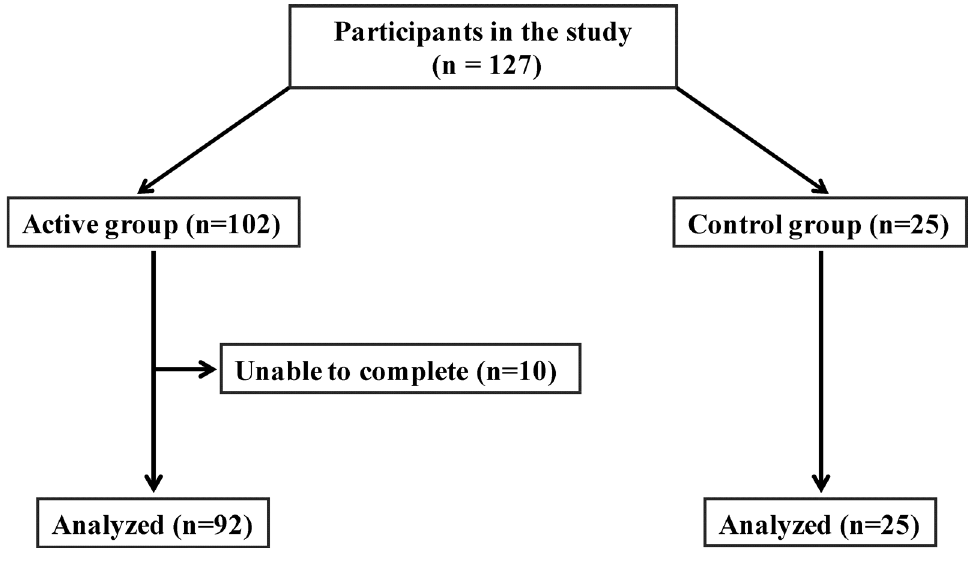
Figure 1. Flow chart of the study